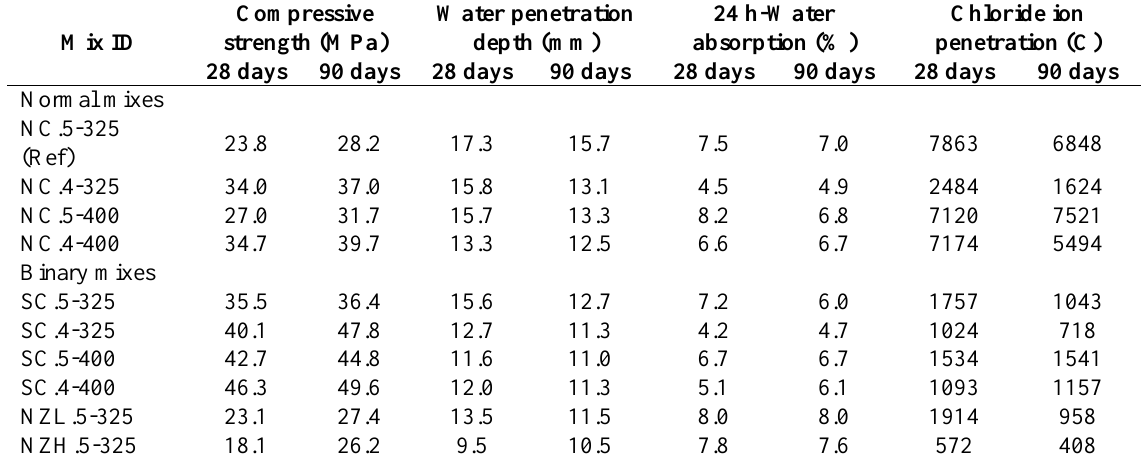
Table 6. Compressive strength and transport